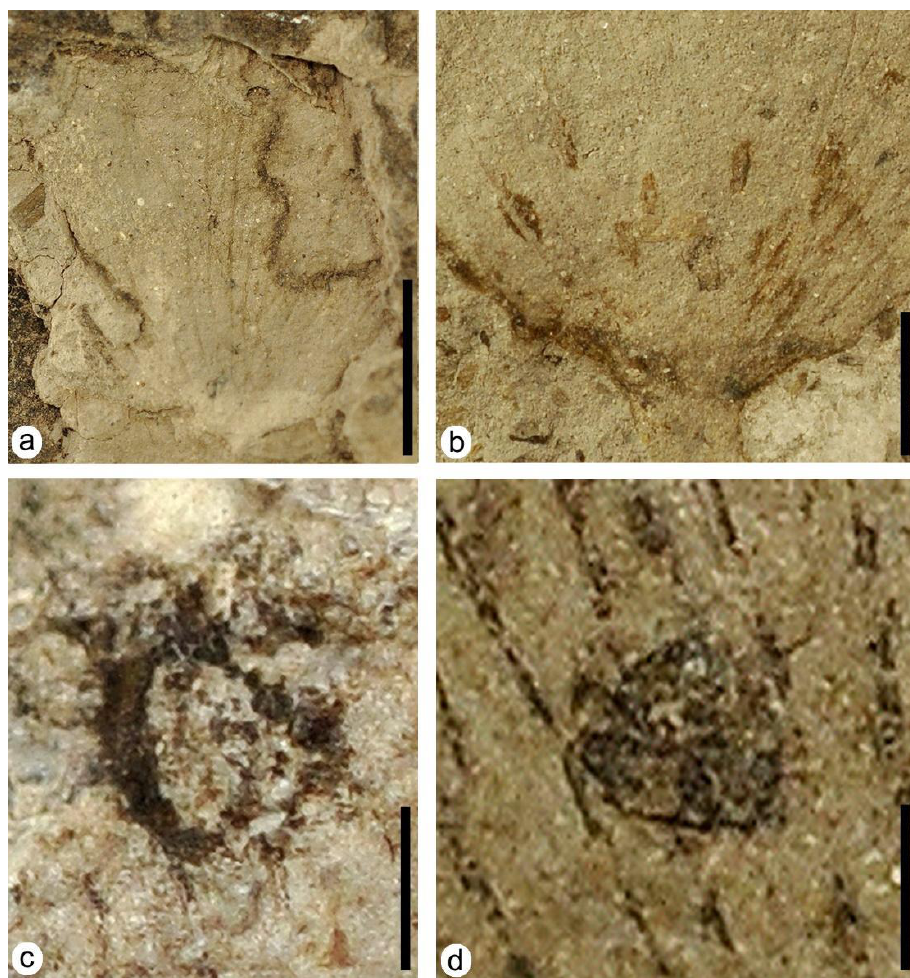
Figure 4. Plant–insect interactions on leaves of the aquatic angiosperm Klitzschophyllites. ( a ) MAP- 8357, a nearly complete leaf with margin feeding DT15. ( b ) MAP-8354 detail of oviposition DT100 at base of the leaf from Figure 3h. ( c ) MAP-8347 detail of mining DT66 from Figure 3d showing tiny serpentiform coprolites in its internal area. ( d ) MAP-8349 detail of galling DT52 from Figure 3e. Scale bars: ( a ) = 1 cm; ( b ) = 5 mm; ( c , d ) = 0.5 mm. DT26: specimen MAP-8348 (Figure 3i). Removal of interveinal tissue in the lower left margin of the leaf with curved veinal stringers